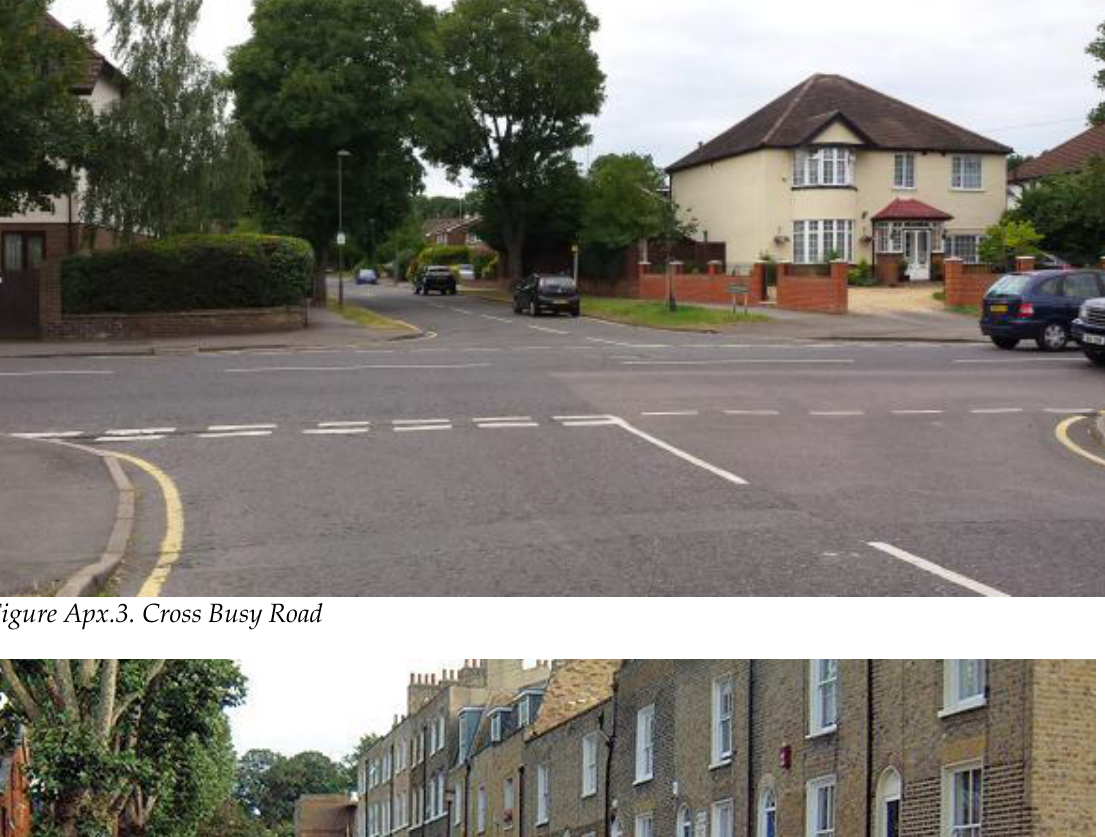
Figure Apx.3. Cross Busy Road